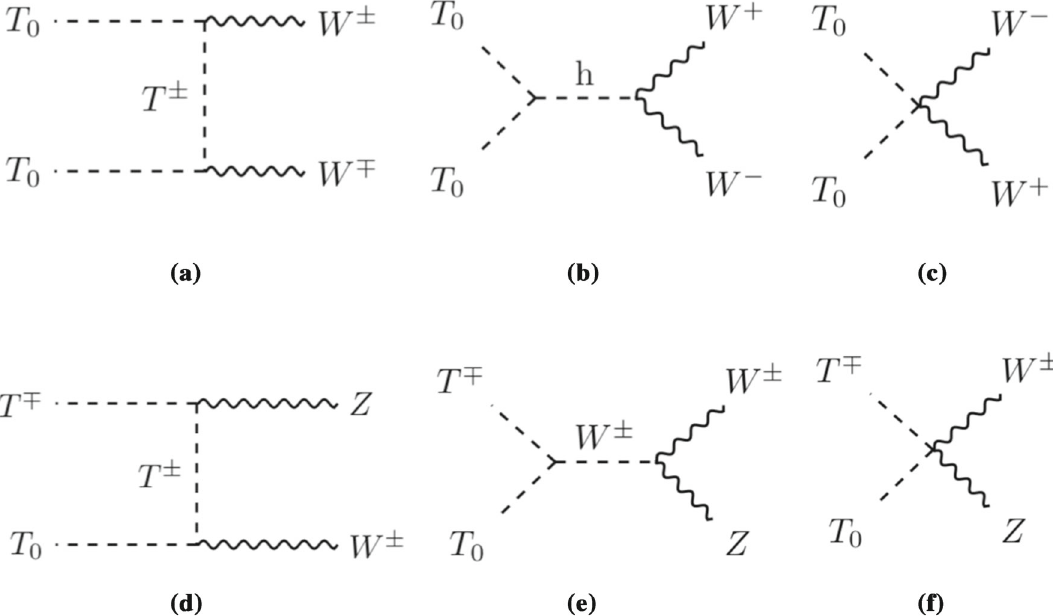
Fig. 9 Dominant annihilation and co-annihilation modes that contribute to DM relic for